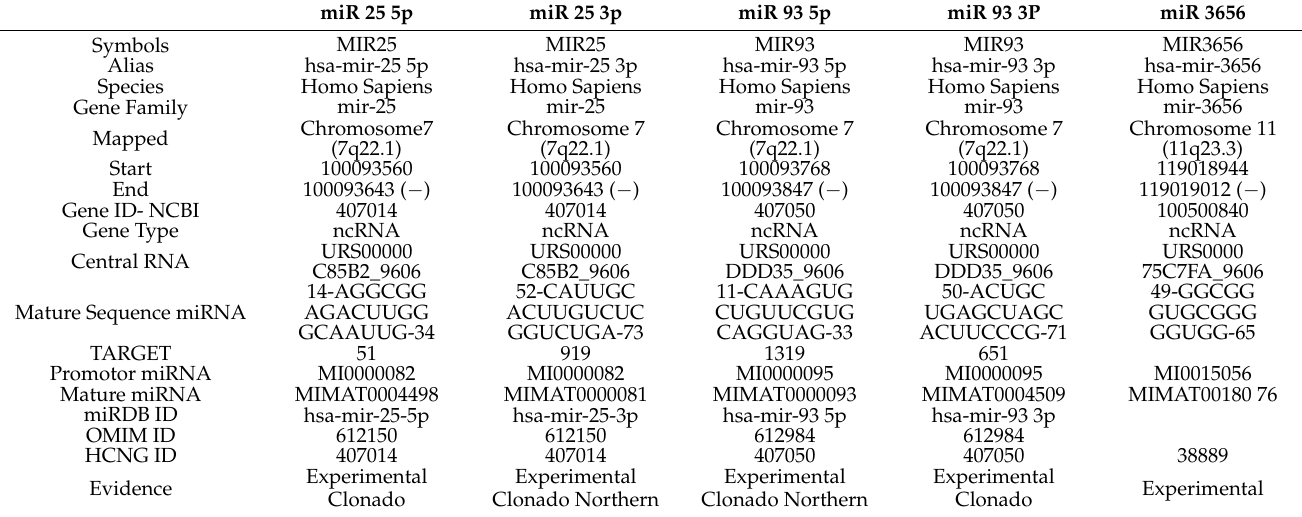
Table 3. Hypermethylated miRNA by MedIP-seq.